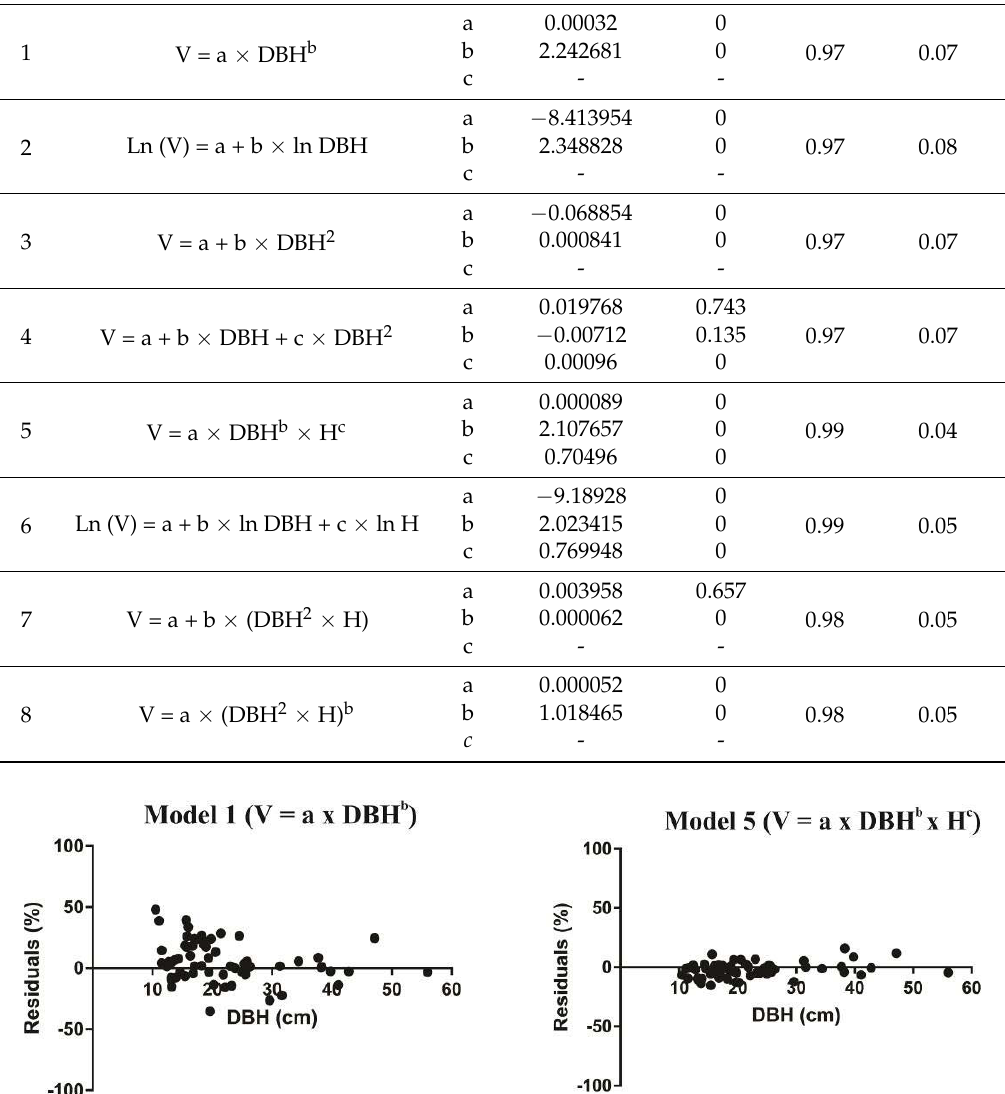
Figure 4. Residuals vs. DBH of the best single input model tested (Model 1) and the best dual input model tested (Model 5).